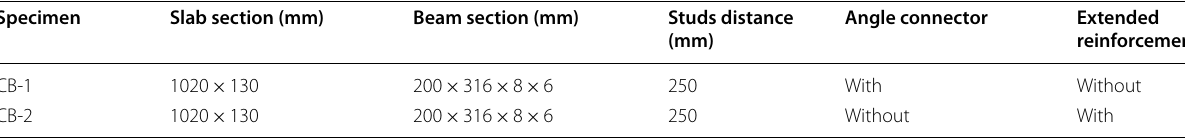
Table 1 Main parameters of the